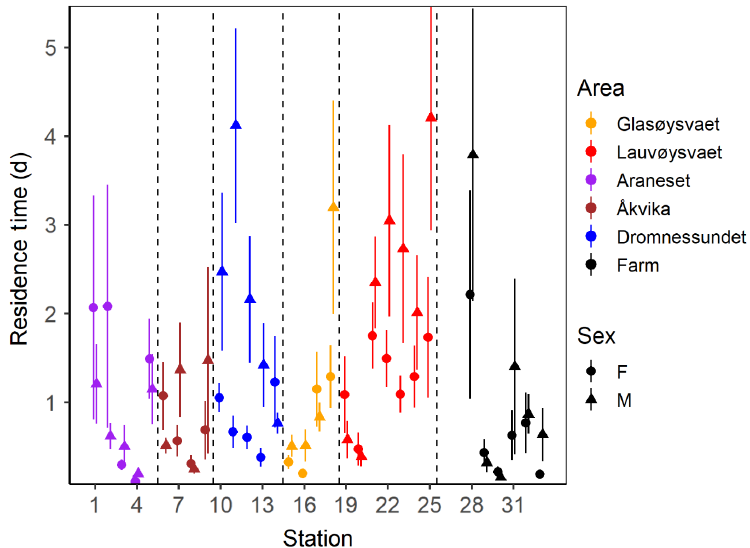
Fig. 4. Residence time during the spawning period for cod at the different stations in the grid. Dotted lines separate different spawning grounds and/or farm sta- tions. Values are shown for both females (circles) and males (triangles) at each station. For each individual fish, the mean residence time at each station was first calculated separately. These values were then used to calculate the mean across all fish present at the station, i.e. the mean of these mean values. Error bars: SE